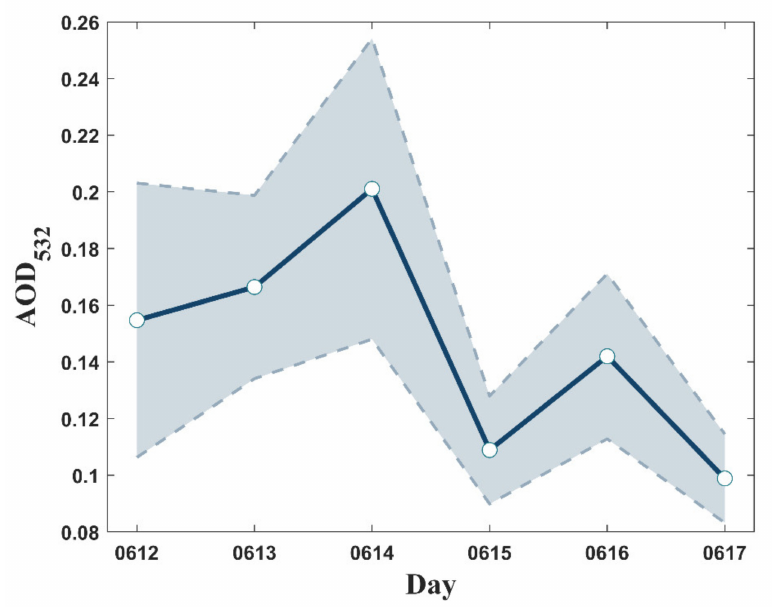
Figure 5. Daily variations in AOD 532 from 12 to 17 June 2019. Blue hollow dots represent the daily average AOD 532 , and the shadow represents the standard